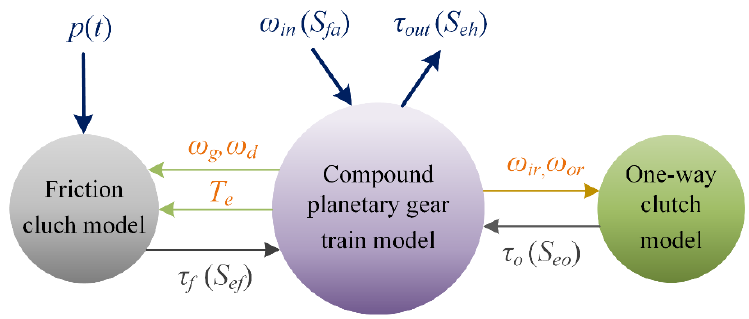
Figure 9. Power transmission relationships among the three basic models.